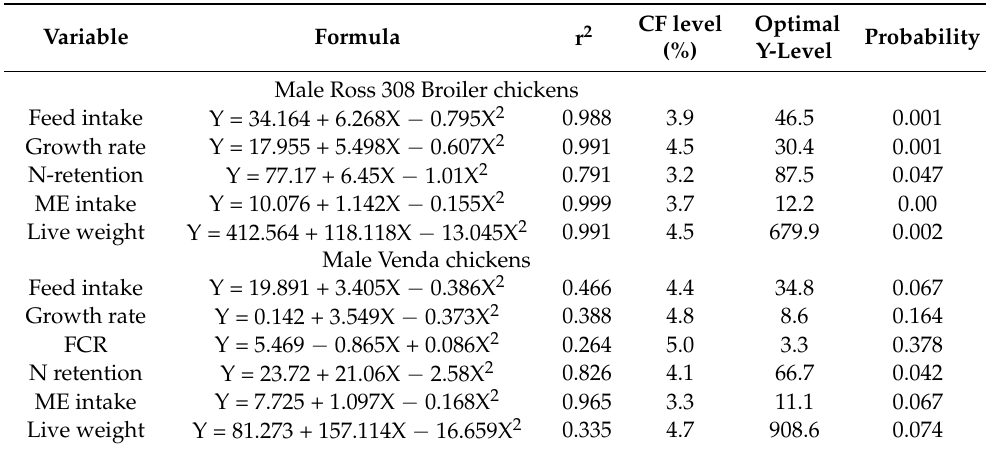
Table 4. The dietary crude fiber levels for the optimal production performance of the male Ross 308 broiler and Venda chickens aged 1 to 21